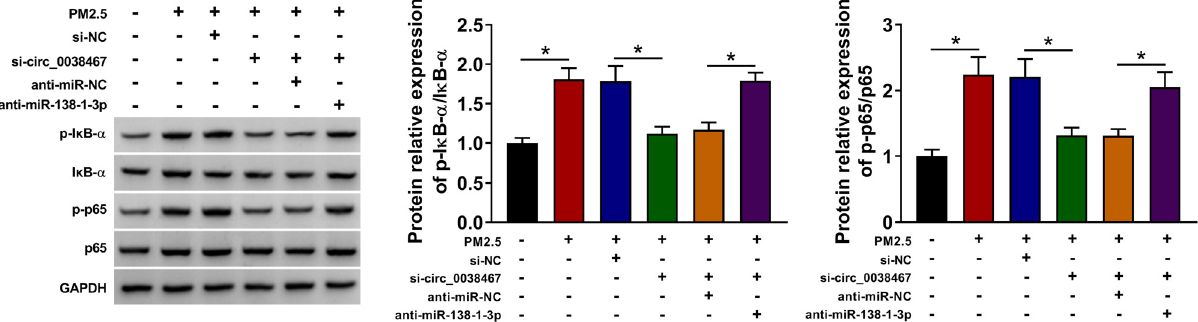
Figure 6: PM2.5 induced the activation of NF - κ B pathway through circ_0038467/miR - 138 - 1 - 3p axis. Western blot analysis of p - I κ B - α and p - p65 levels in BEAS - 2B cells transfected with si - NC, si - circ_0038467, si - circ_0038467 + anti - miR - NC, or si - circ_0038467 + anti - miR - 138 - 1 - 3p under PM2.5 exposure. N = 3, * P <